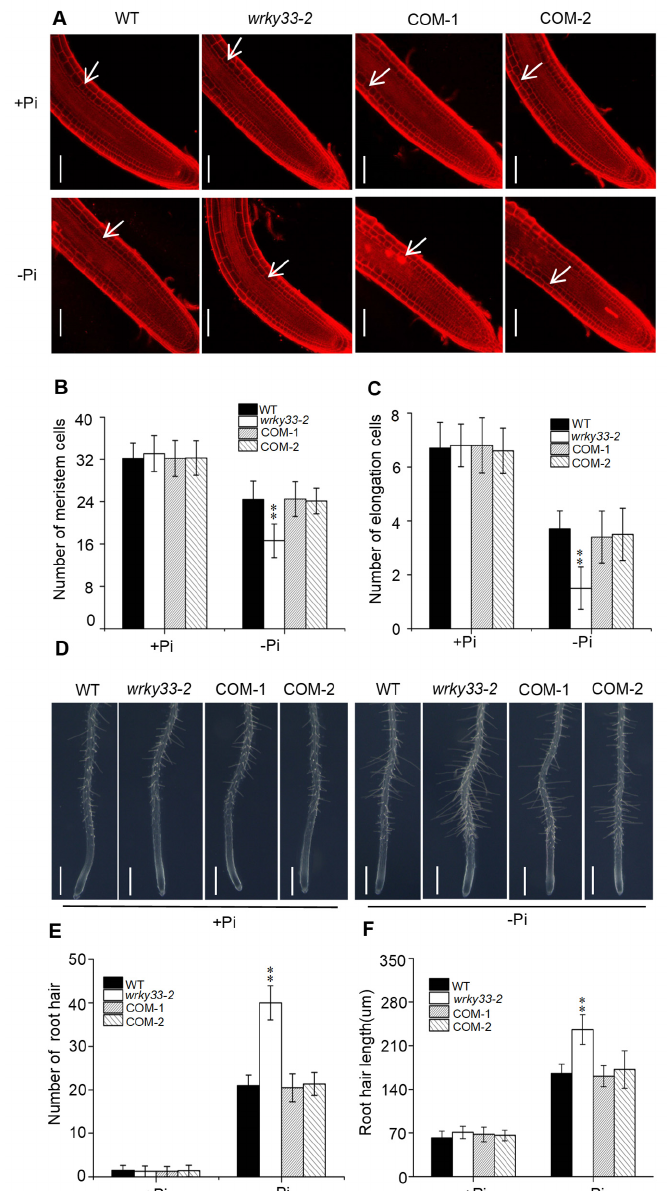
Figure 2. WRKY33 controls the root architecture under the Pi-deficient condition. ( A ) Confocal images of root tips of WT and mutants with propidium iodide staining. Four-day-old seedlings of WT and mutants were transferred to Pi deficiency ( − Pi) or Pi sufficiency (+Pi) for three days. White arrows indicate the position above which is the last meristem cell. Bar = 50 µ M. Statistics of the number of meristematic cells ( B ) and elongation cells ( C ) in roots as indicated in ( A ). The cortex cell between the quiescent center and the first elongated cell were countered as the meristem cells. Data are means ± SD from three independent experiments ( n = 8; n represents the number of samples). ( D ) Root hair growth phenotype. Four-day-old seedings of WT, wrky33-2 , COM-1, and COM-2 were transferred to a Pi-sufficient (+Pi) or a Pi-deficient ( − Pi) medium for three days. The experiments were repeated three times with similar results. Bar = 200 µ M. ( E , F ) The root hair number ( E ) and the root hair length ( F ). The hair density and length measured within a 1 mm zone in the root starting from the root tip. Data are means ± SD from three independent experiments ( n = 15; n represents the number of samples). Asterisks in ( B , C , E , F ) indicate a significant difference from the WT (Tukey’s test; **, p <